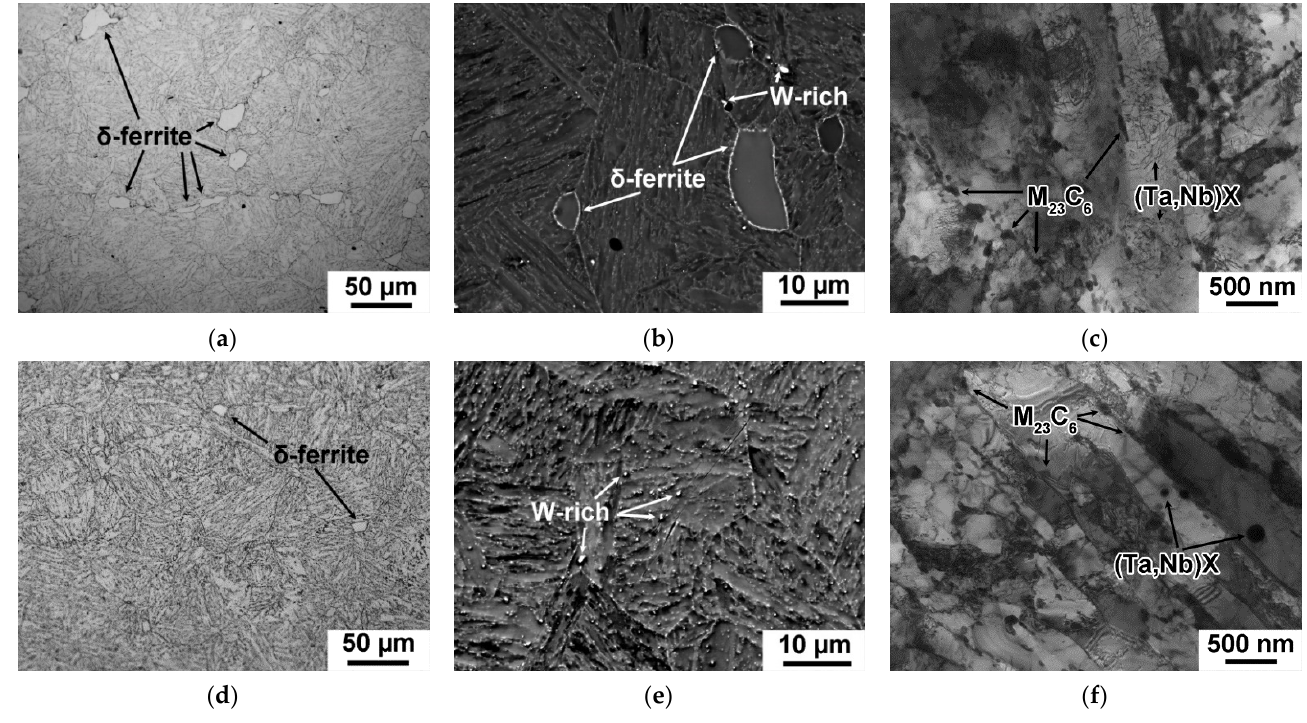
Figure 6. Typical microstructures in the 12CrTaNb0.003N steel subjected to the CHT ( a – c ) and TMP ( d – f ) obtained by optical microscope ( a , d ), SEM ( b , e ), and TEM ( c , f ).